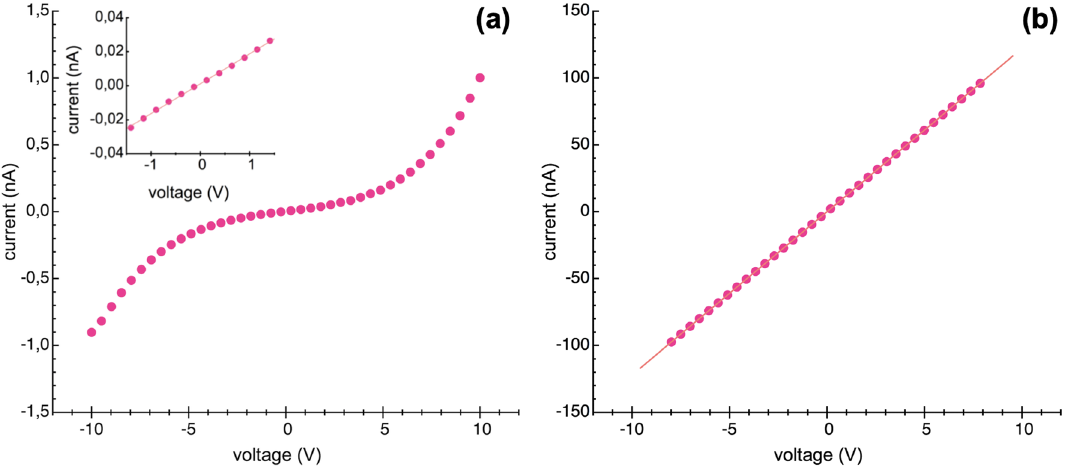
Fig. 3 Dark I – V characteristics of the non-annealed a and annealed b Ge NW network devices, respectively. The inset in a shows the magnifi- cation of I – V curve at low bias (± 1.5 V). The line in b represents the linear fit of the